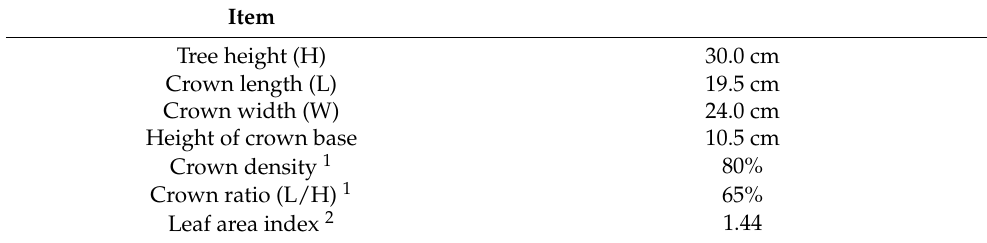
Table 1. General properties of the model tree.